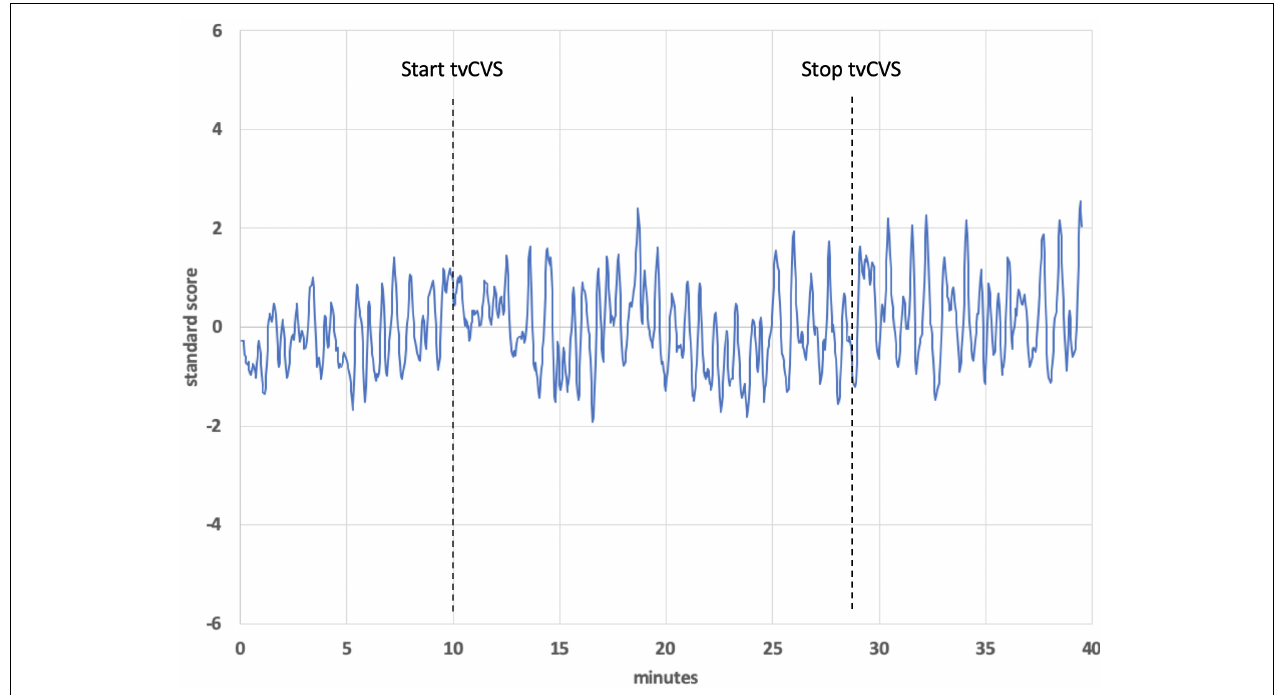
FIGURE 10 | Time series from a frontoparietal independent component, subject 1. The dotted lines show the start and stop points of the tvCVS